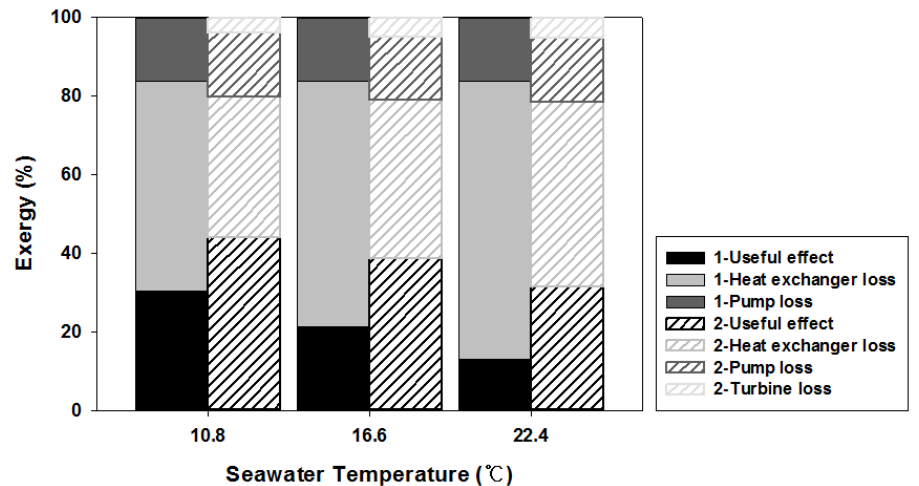
Figure 12. Exergy efficiency at different seawater